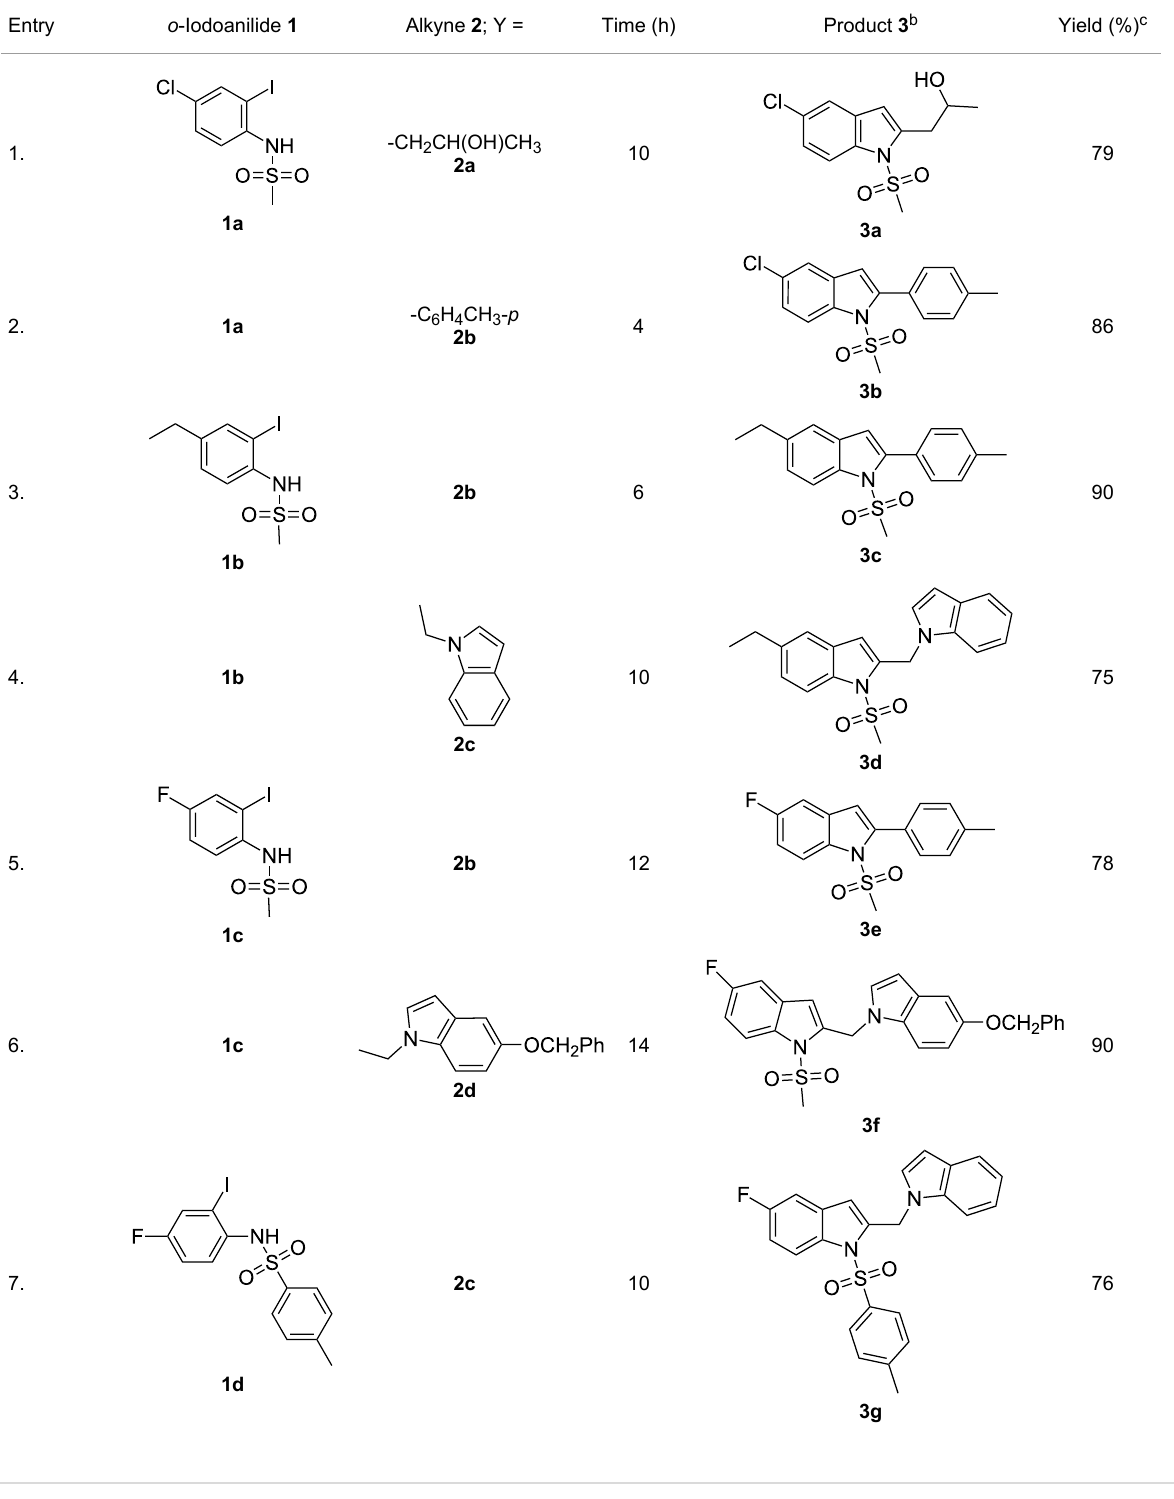
Table 1: Pd/C-Catalyzed synthesis of 2,5-disubstituted N -sulfonyl-indoles in aqueous media. a